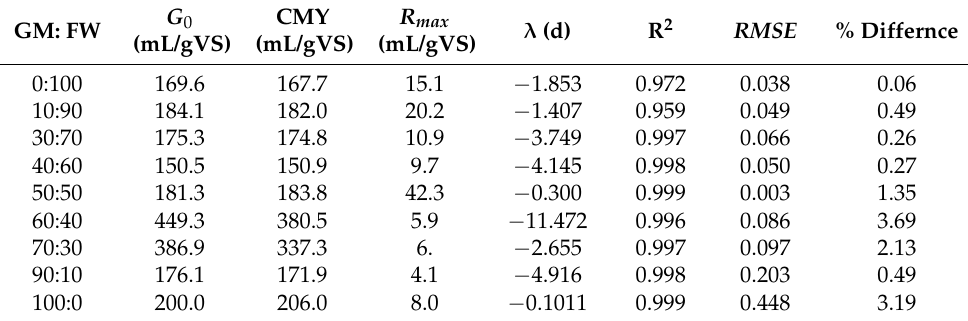
Table 3. Gompertz model parameters for GM: FW